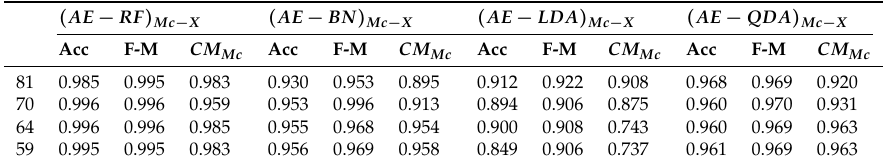
Table 11. Performance evaluation of the proposed framework in multi-class classification using